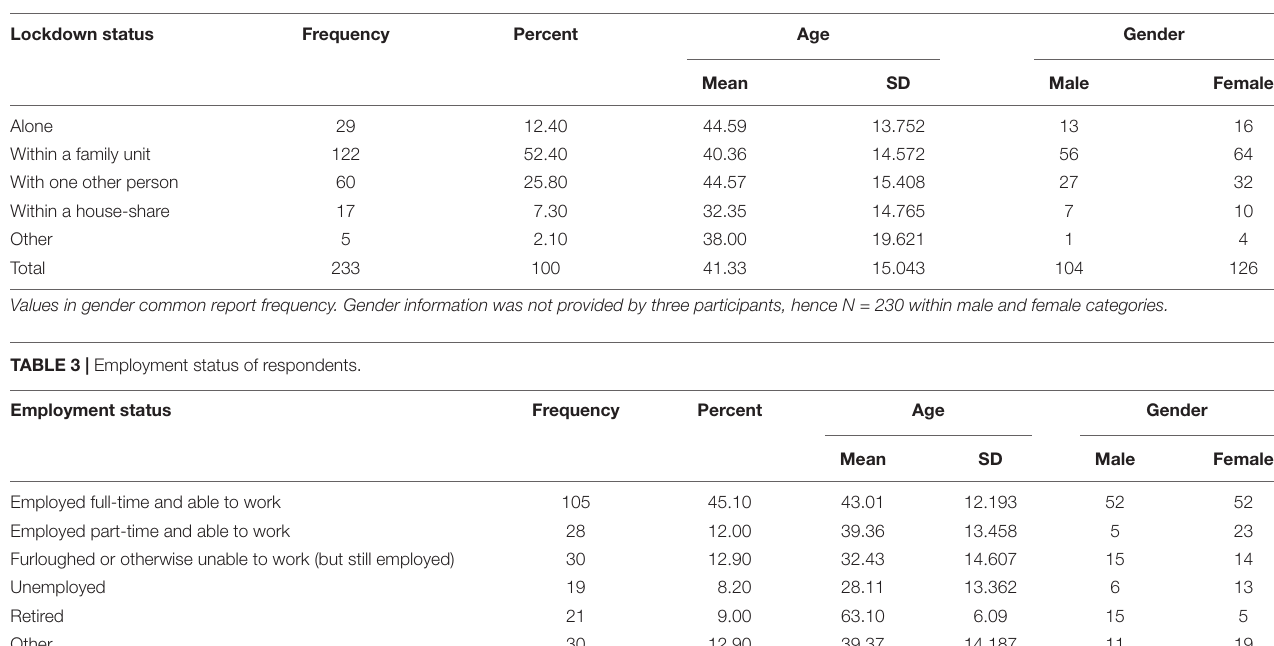
TABLE 2 | Lockdown status of respondents.